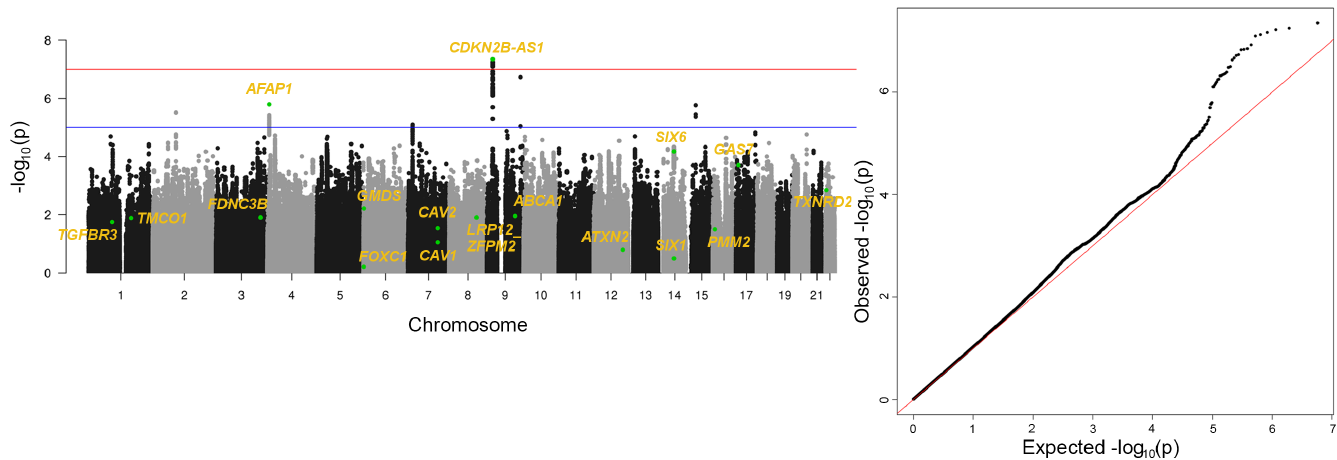
Fig 1. POAG GWAS Results in eMERGE dataset. (A) Manhattan plot shows chromosome and base pair positions on x-axis and -log10 of p-value on y- axis. Each point here represents a SNP. Red line is the genome-wide significance line at 5e-08. Highlighted points indicate annotation of SNPs with previously reported GWAS associated genes. (B) Shows a QQ-plot from GWAS